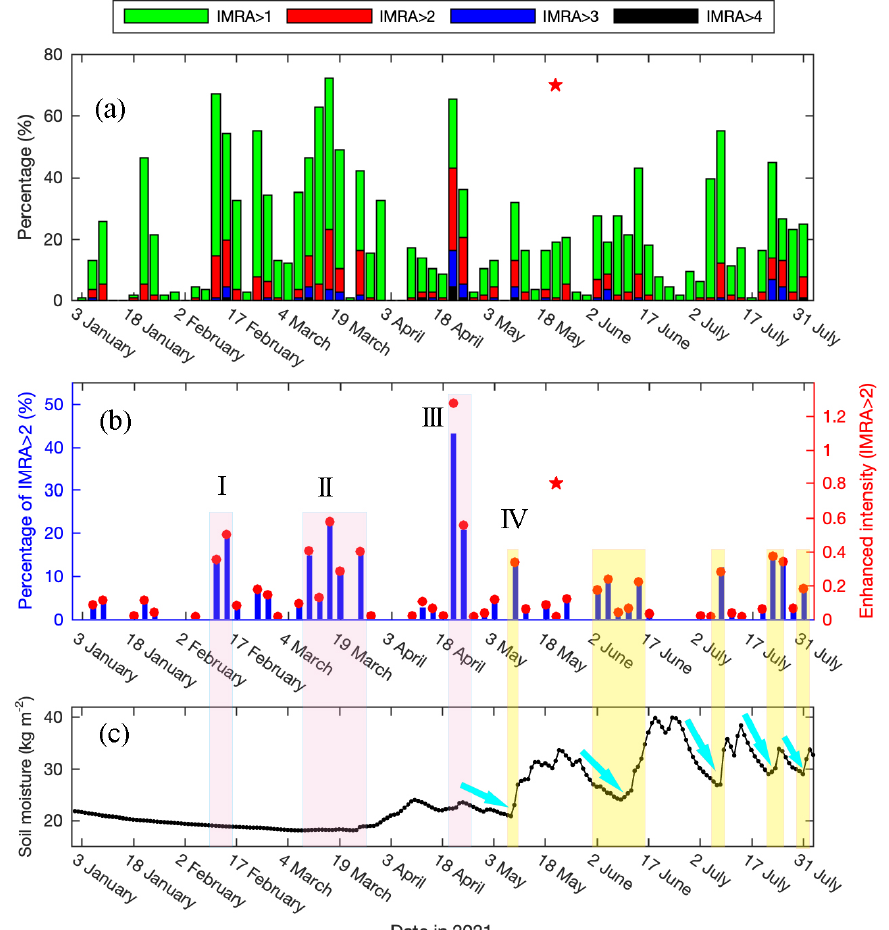
Figure 3. Time series of IMRA and soil moisture during the period of January to July 2021 in the seismogenic fault zone. ( a ) Percentages of IMRA with different scales; ( b ) temporal variation in IMRA > 2 around the occurrence of Madoi earthquake; ( c ) temporal variation in soil moisture. Roman numerals indicate four phases with increased IMRA prior to the main event. Pink bars indicate the variations independent of soil moisture, and yellow bars indicate the variations caused by the decrease in soil moisture. Cyan arrows indicate the behavior of the decrease in soil moisture.